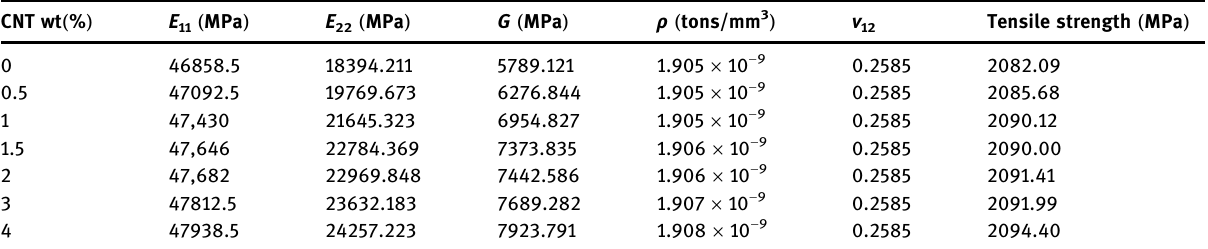
Table 9: Mechanical properties of CNTFPC rebar for di ff erent CNT weight ratios using multi - scale analysis